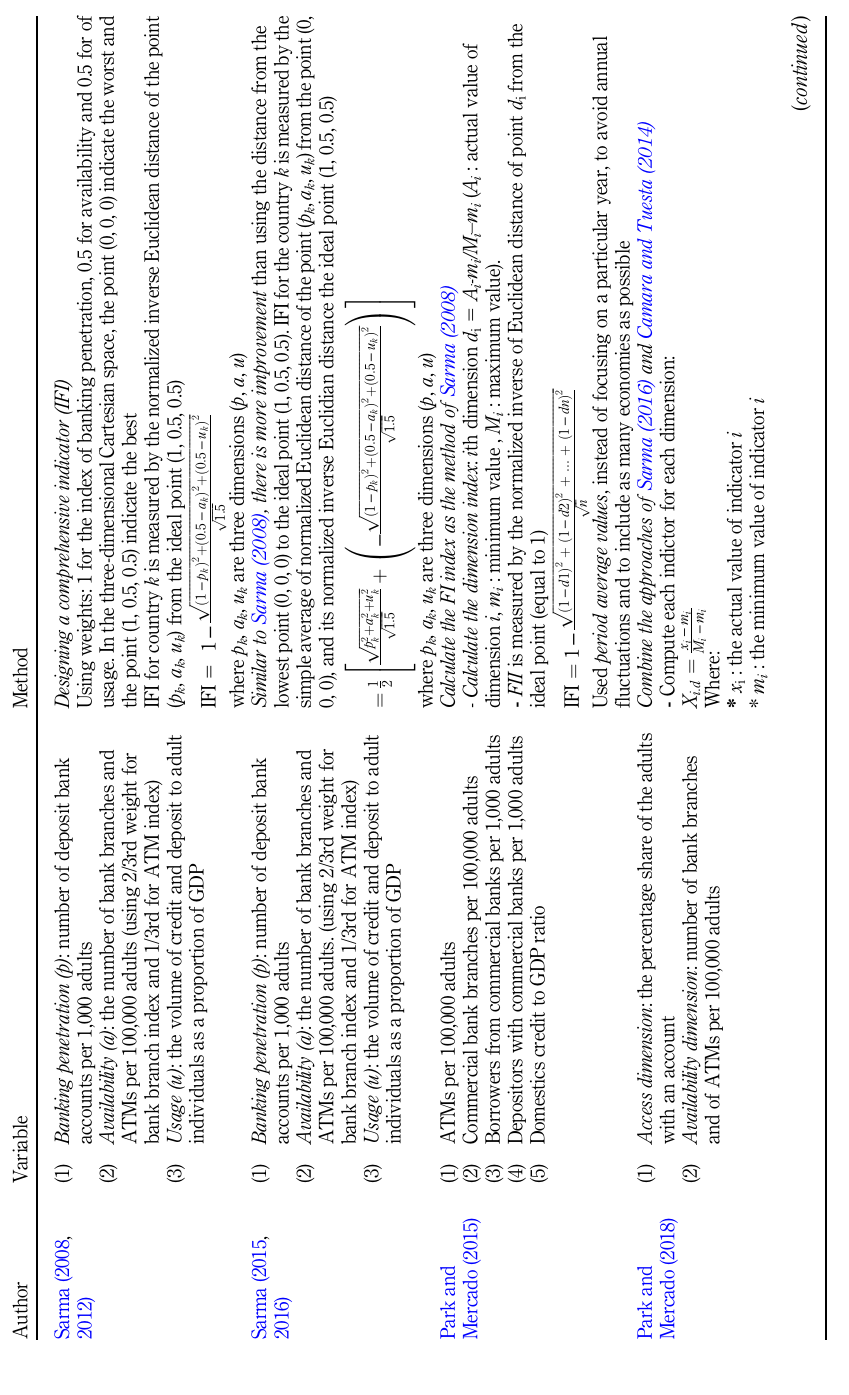
ffiffiffiffiffi 5 1 : p